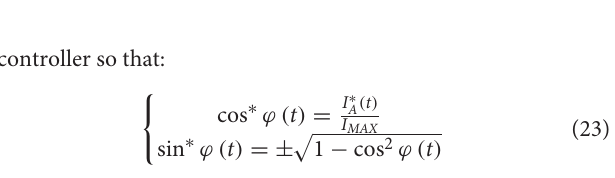
FIGURE 3 | Block diagram of PWM ac-to-ac converters and associated